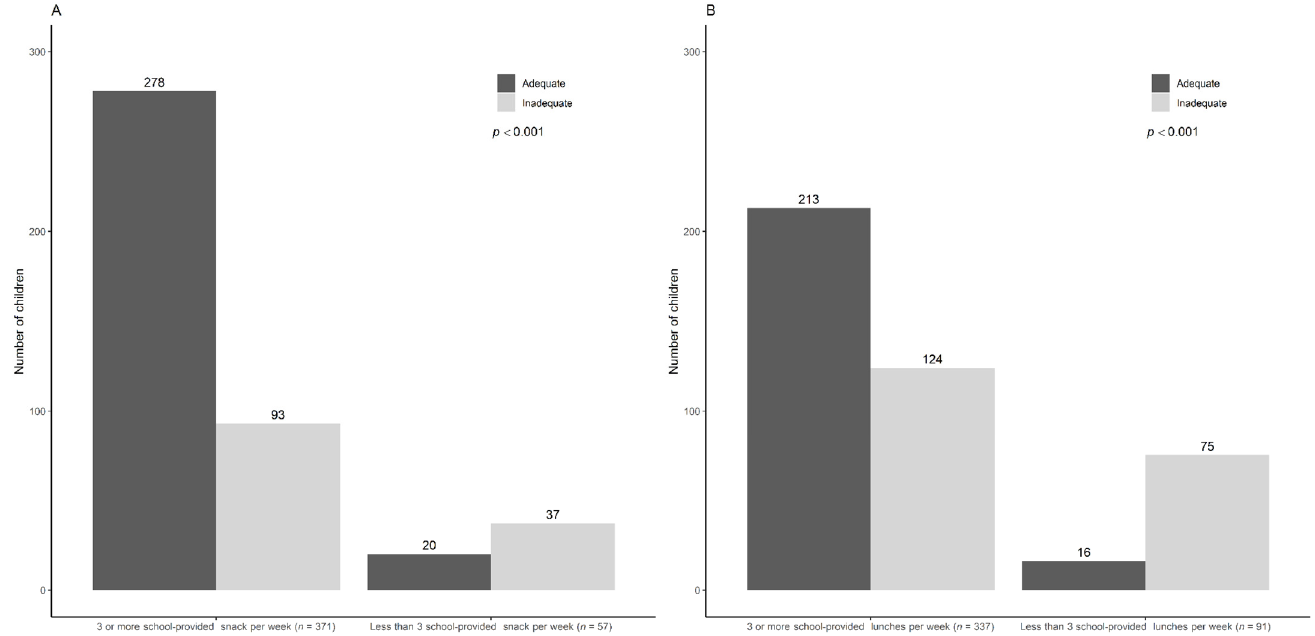
Figure 1. School canteen’s influence Monday to Friday. ( A ) Snacks. ( B ) Lunch.